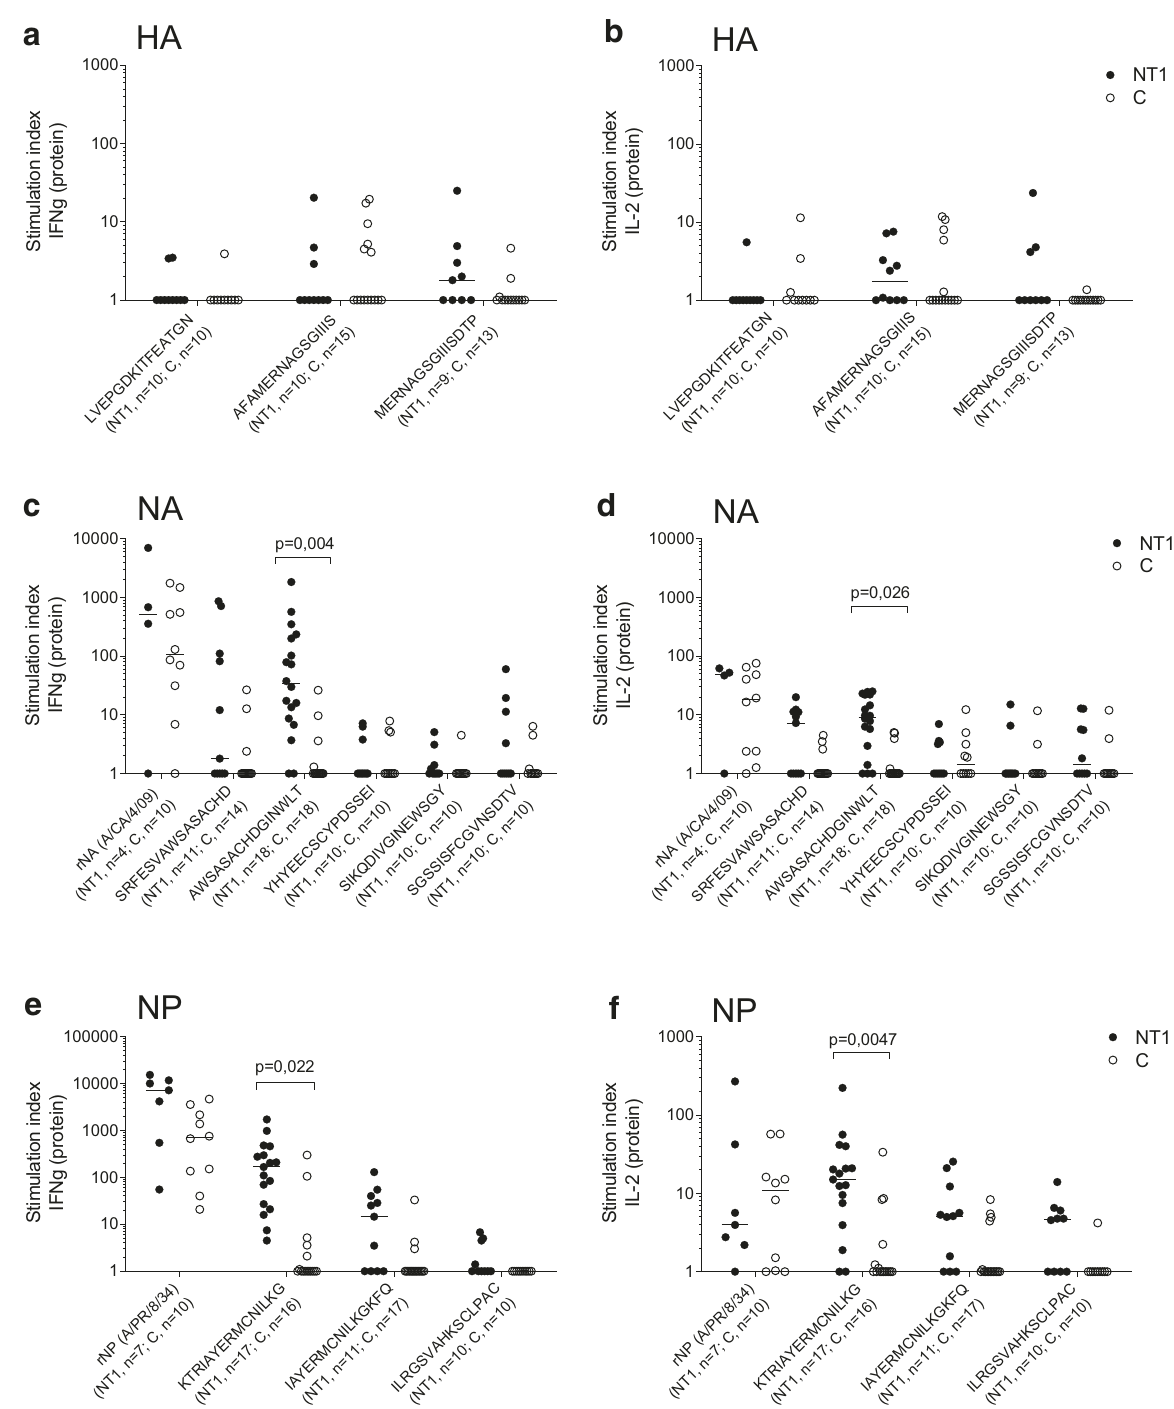
Fig. 3 Identi fi cation of in fl uenza A H1N1 virus T-cell epitopes in Pandemrix-associated NT1 patients. PBMC from pediatric Pandemrix-associated NT1 patients (NT1) or pediatric Pandemrix-vaccinated healthy controls (C) were stimulated in culture with single 15-mer peptides from in fl uenza (A/ reassortant/NYMC X-179A (California/07/2009 × NYMC X-157)(H1N1)) vaccine virus hemagglutinin (HA), neuraminidase (NA) or nucleoprotein (NP) (discovery cohort). Recombinant neuraminidase (rNA) and nucleoprotein (rNP) were used as positive controls. The secretion of IFN- γ ( a , c , e ) or IL-2 ( b , d , f ) was measured by FMIA (protein). Results are expressed as the ratio between cytokine concentrations measured in peptide-stimulated and negative control samples (stimulation index). Statistical comparisons between groups were performed, using Kruskal – Wallis and Dunn ’ s multiple comparisons tests.